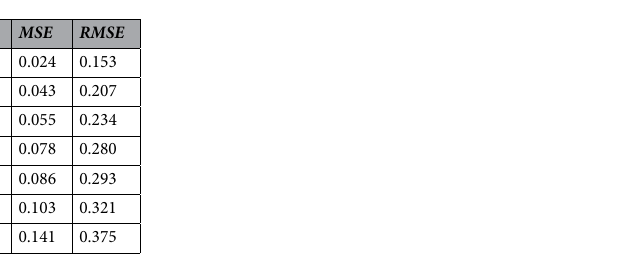
Table 2. Analytical criteria for models